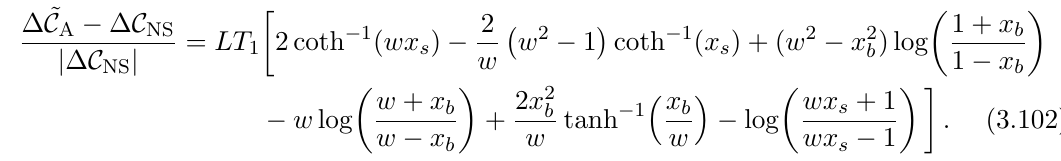
Figure 11. Rate of change of complexity evolving both boundaries as t z = 1 =w , ~ ‘ ct = 1 and (cid:11) = 1. In the left we evaluate T 2 t w = 2 and in the right T 2 t w = 6, and the blue curve is the rate of change with the inclusion of counterterm, while the red line is the rate of change without it. Despite being a shock wave that doubles the temperature, the rate of change is exactly zero without the inclusion of the counterterm for t c 0 < t < t c 1 , as opposed to being proportional to the di(cid:11)erence of masses. In addition, there is a large positive peak after t c 1 for the red curve, in contrast to the (short) negative spike of the blue curve. The peak in the red curve in the right (cid:12)gure is similar to the one in the left, but is sharper and reaches higher values the earlier the shock wave is sent. Finally, the late time limit is given by eq. (3.101), in contrast to ( M 1 + M 2 ) =(cid:25) , as discussed in section